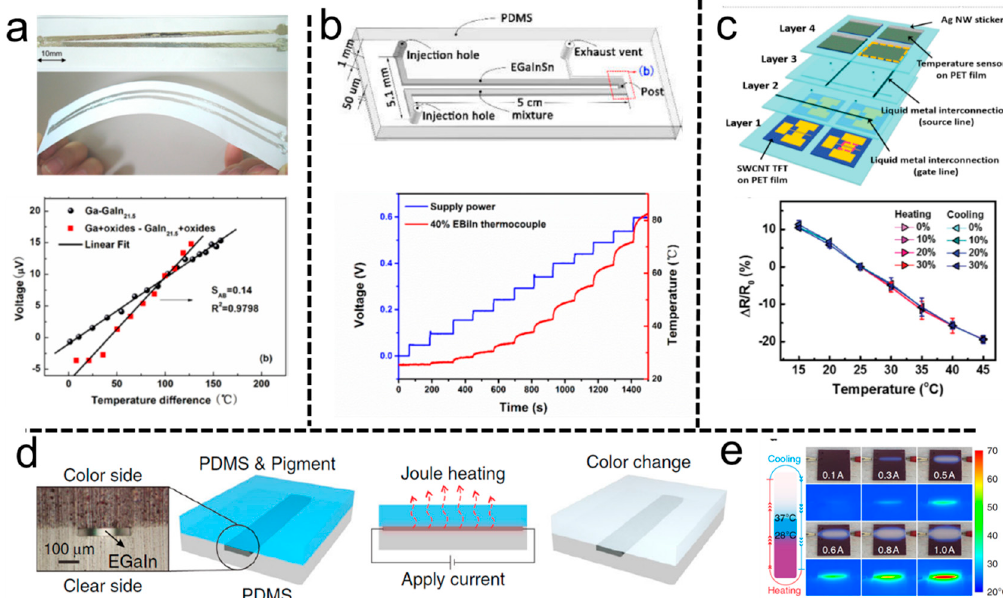
Figure 9. Liquid metal temperature sensors. ( a ) The top is the Ga based thermocouple written on the paper. The bottom is the measured thermoelectric voltage as a function of temperature difference [3]. Rights managed by AIP Publishing. ( b ) Schematic of micro-thermocouple; One channel was filled with EGaInSn, and the other was filled with a low-melting-point Bi-based metal alloy mixture. The bottom shows the relationship between supply power and temperature [103]. Copyright (2019) by the authors. ( c ) Schematic of the stretchable temperature sensor array consisting of the liquid metal circuit. The resistance change of the sensor at a different temperature under a biaxial strain of up to 30% [106]. Copyright (2016) WILEY-VCH. ( d ) Schematic of the color displayed sensor consisting of a liquid metal circuit between two layers of PDMS. Joule heating changes the color of the pigment in the PDMS. ( e ) The sensor with blue and red pigments that alter color in response to heat [65]. Copyright (2019) Springer Nature.